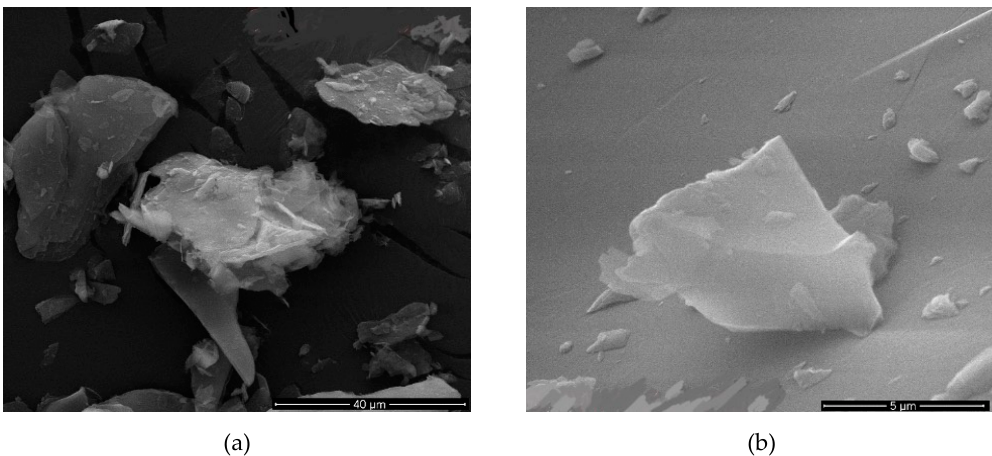
Figure 13. SEM images of M x2c1 sample with a sonication time of 9 h with higher magnification ( a ) 1000×; ( b ) 20,000×. Minerals 2020 , 10 , 572